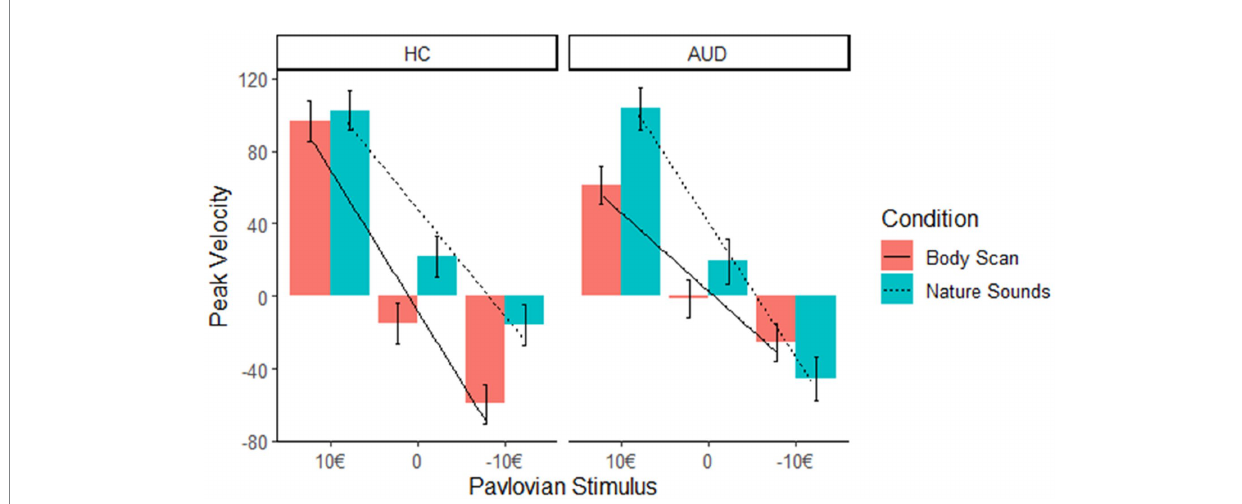
FIGURE 3 In AUD participants, the slope of peak velocity regressed on Pavlovian CS was not significant, indicating a decreased PIT effect after the body scan versus nature sounds condition in the AUD group